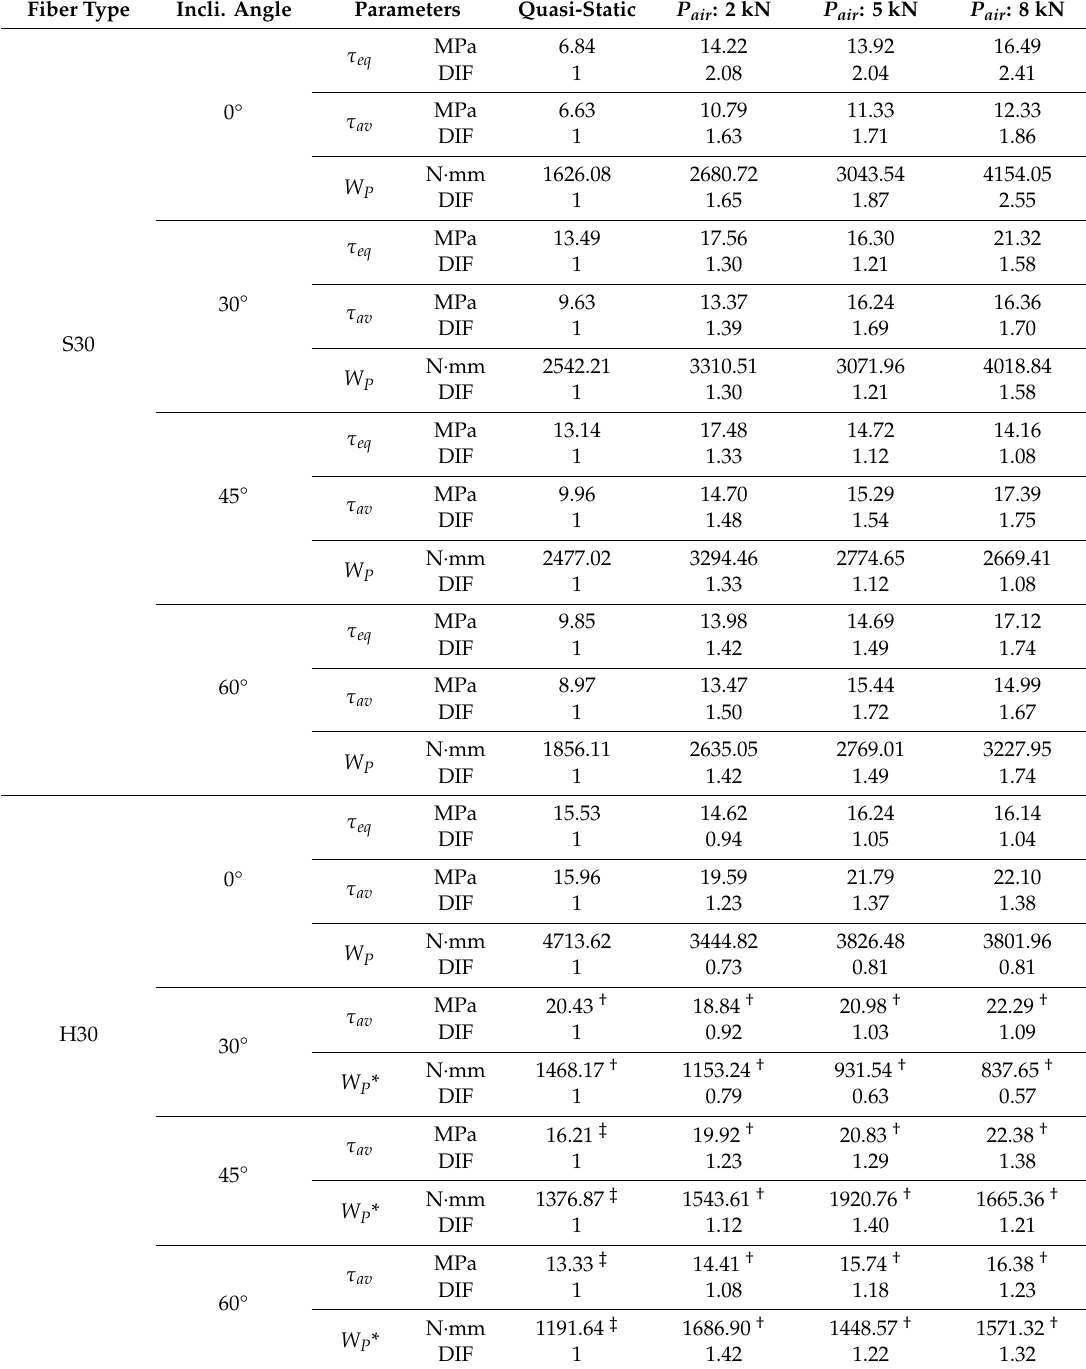
Table 5. Summary of quasi-static and impact pullout test